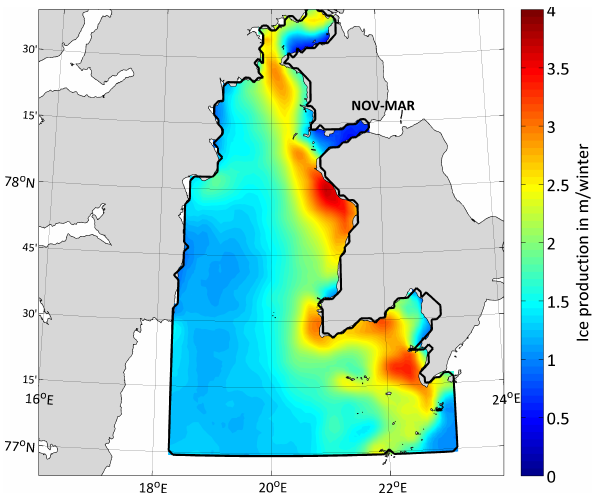
Figure 8. Spatial distribution of the interannual mean accumulated ice production (IP) rate in mwinter − 1 . Values are first accumulated for each winter season from November to March and afterwards averaged for 2002/2003 to 2013/2014.